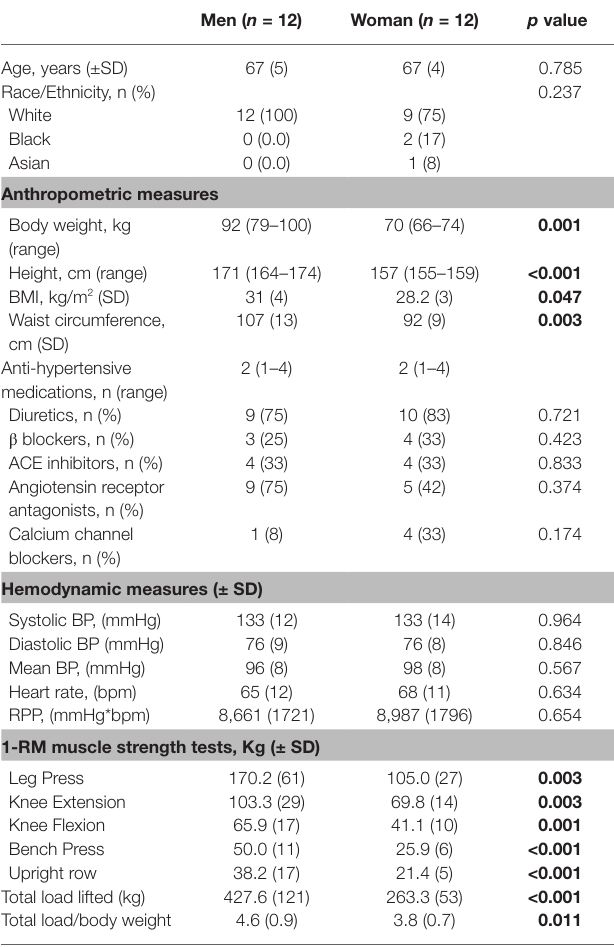
TABLE 1 | Selected participant